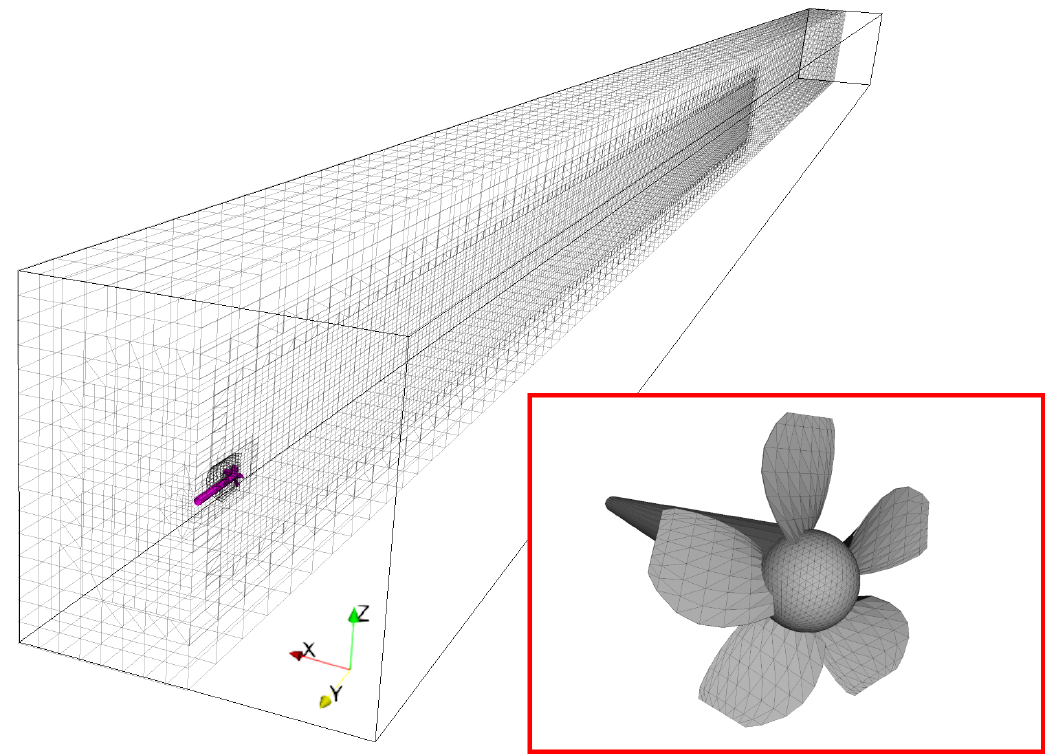
Figure 1. An illustration of the propeller system (coloured pink) within the three-dimensional domain. A cross-sectional slice (in the y – z plane) through the computational mesh is included to highlight the cylindrical and cuboidal regions of enhanced resolution. The vertices within the cylindrical region dynamically rotate throughout the simulation to model the motion of the propeller. A computer-aided design (CAD) rendering of the full propeller system, including the shaft and hub, is